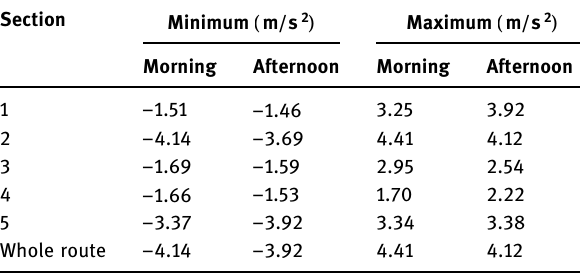
Table 4: Summary of extreme lateral acceleration values Section